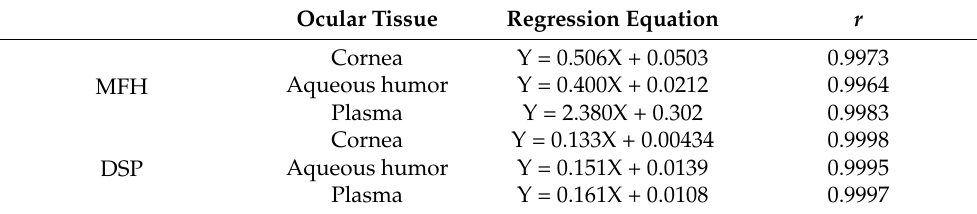
Table 1. Regression equation and correlation coefficient ( r ) of MFH and DSP in ocular tissue.